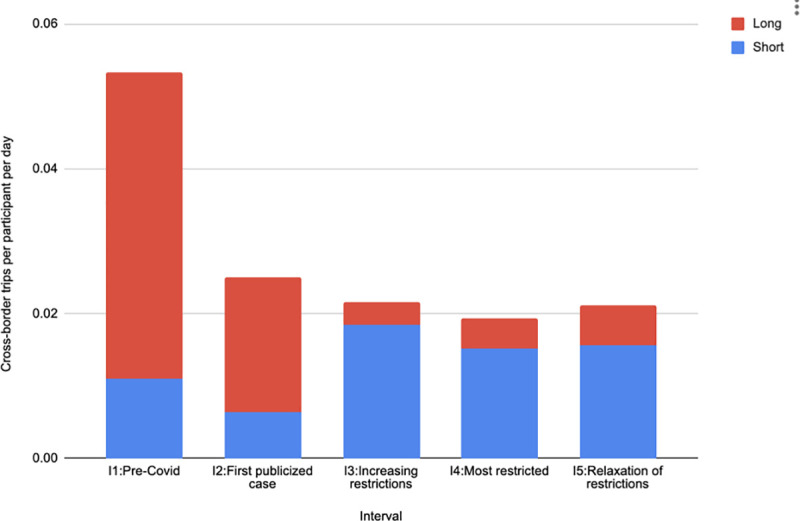
Number of cross-border trips per participant per day in each interval, broken down into long and short trips.Short trips are defined as those for which the maximum distance from the border is less than 500 meters and long trips are those greater than 500 meters.